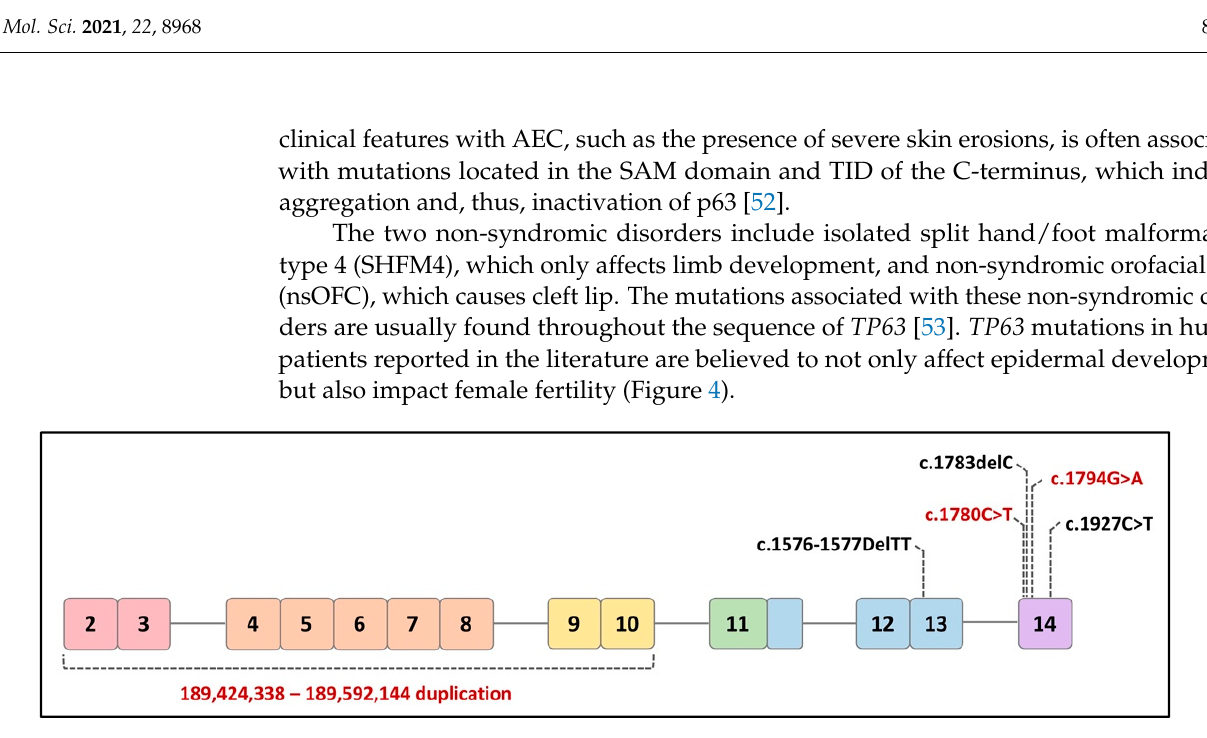
Figure 4. Distribution of mutations in TP63 α associated with infertility in human patients. The red text indicates the isolated POI, and the black text indicates syndromic POI.